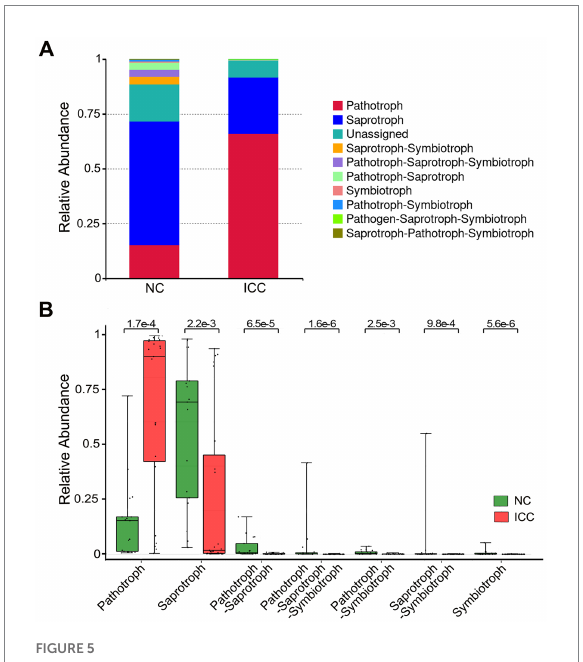
FIGURE 5 Functional predictive analysis between the ICC and NC groups. Stacked bar plot of the predominant functional classification at the trophic modes (A) . Wilcox rank-sum test was applied to the guild annotated results (B) . Control, healthy controls; ICC, intrahepatic